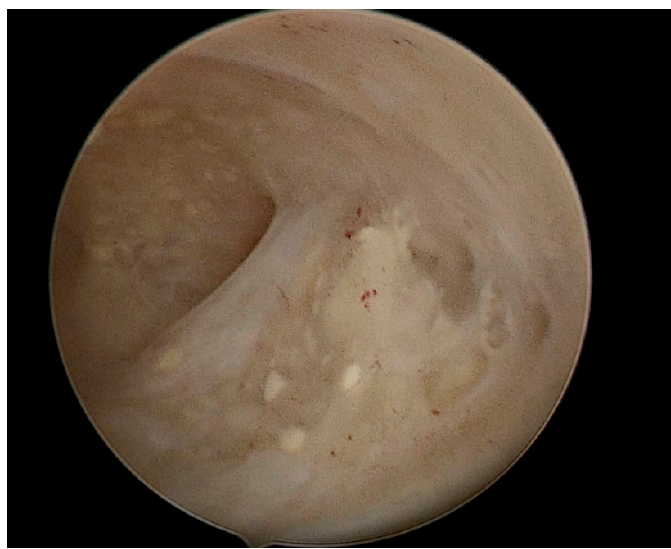
Figure 3. Hysteroscopic image of atypical endometrial hyperplasia (AEH).